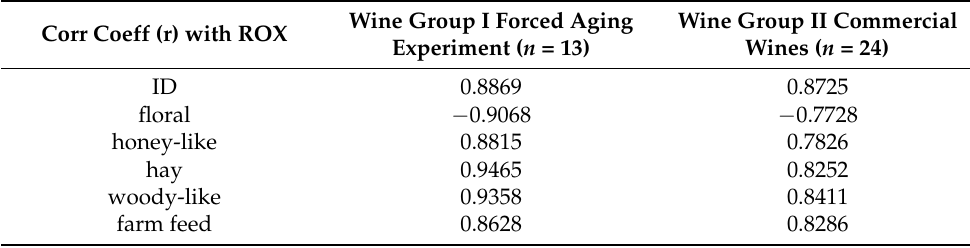
Table 7. Coefficients of correlation between sensorial descriptors and dROX Values from Group I and Group II